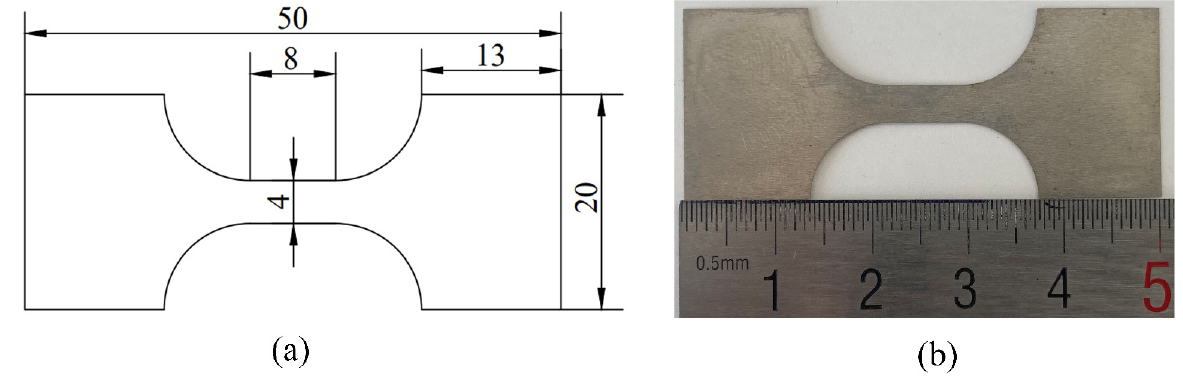
Figure 2. Tensile test specimens: ( a ) designed specimen; ( b ) machined specimen.